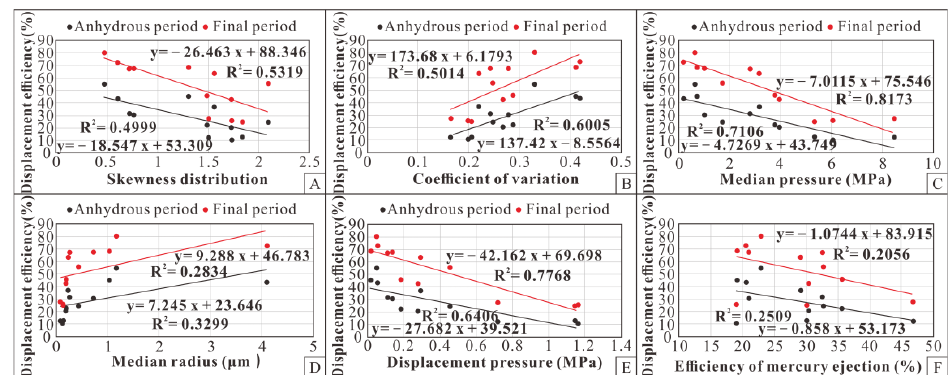
Figure 24. Correlation between pore-throat structure parameters and water-flooding efficiency. ( A ) Correlation between skewness distribution and displacement efficiency. ( B ) Correlation between coefficient of variation and displacement efficiency. ( C ) Correlation between median pressure and displacement efficiency. ( D ) Correlation between median radius and displacement efficiency. ( E ) Correlation between displacement pressure and displacement efficiency. ( F ) Correlation between efficiency of mercury ejection and displacement efficiency.